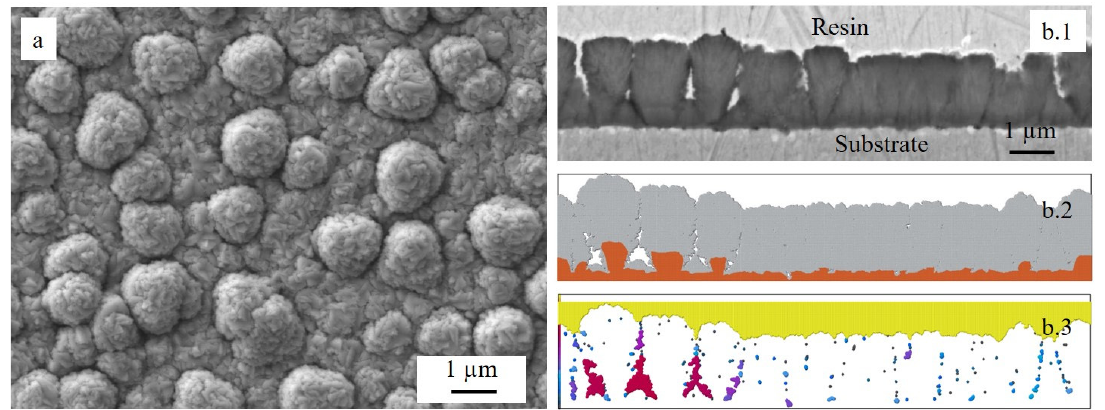
Figure 8. Backscattered electron image of the steel substrate after 1 h of pre-oxidation at 800 °C in ambient air: ( a ) surface and ( b ) cross section. Figure 9. Morphology of the Ti PVD coating deposited on the pre-oxidized steel: ( a ) surface and ( b.1 ) cross section, ( b.2 ) simulated film growth using NASCAM, and ( b.3 ) porosity of the simulated film.